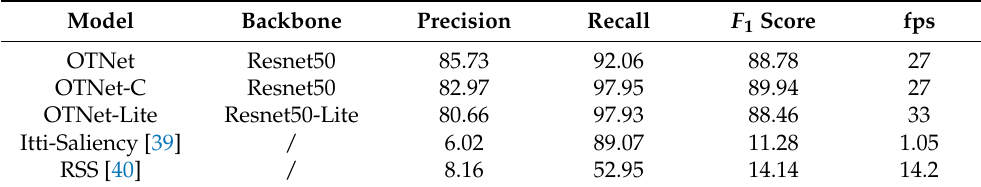
Table 4. The location performance results of the